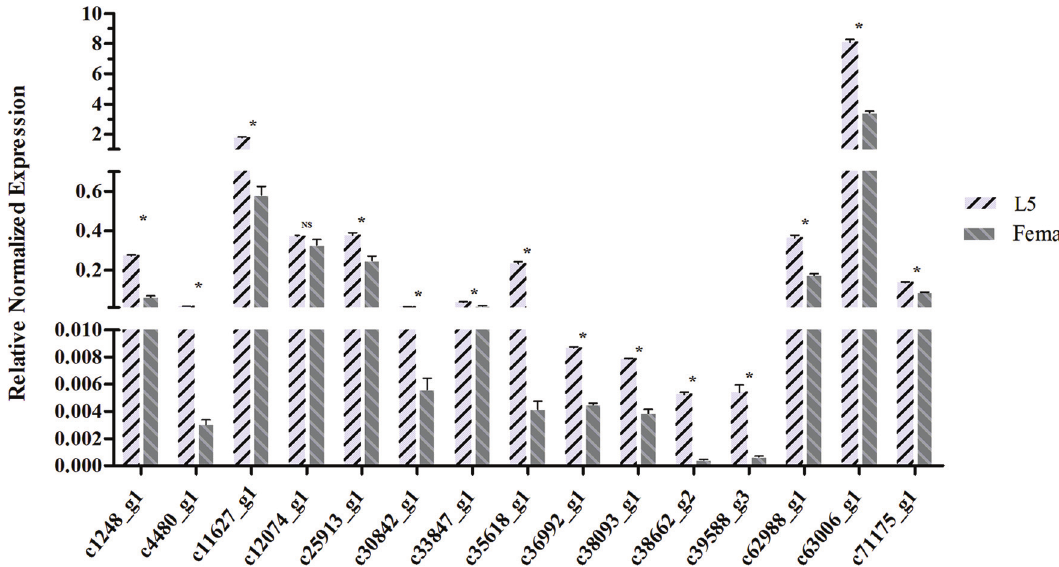
Figure9 -qPCRvalidationsfor15DEGsinthelysosomalpathway.AnasteriskindicatesasignificantdifferencebetweenL5andfemaleadultexpression levels (p < 0.05, Student’s t -test). NS – no significant difference. The columns are the mean (cid:5) SEM (n = 3 per